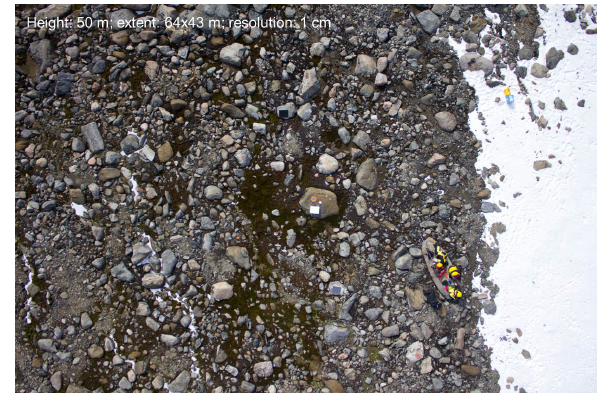
Figure 4: DSLR photograph for a section of moss